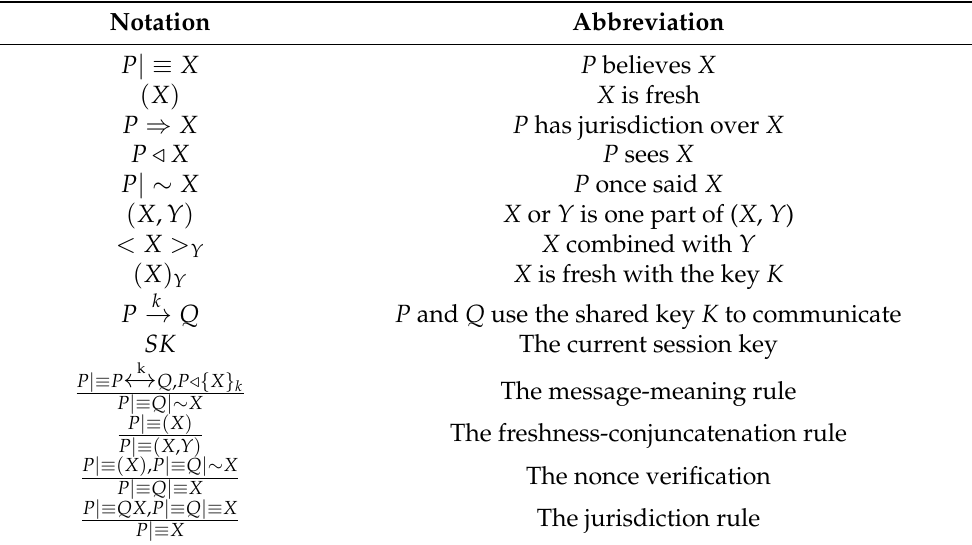
Table 2. Notations and logical